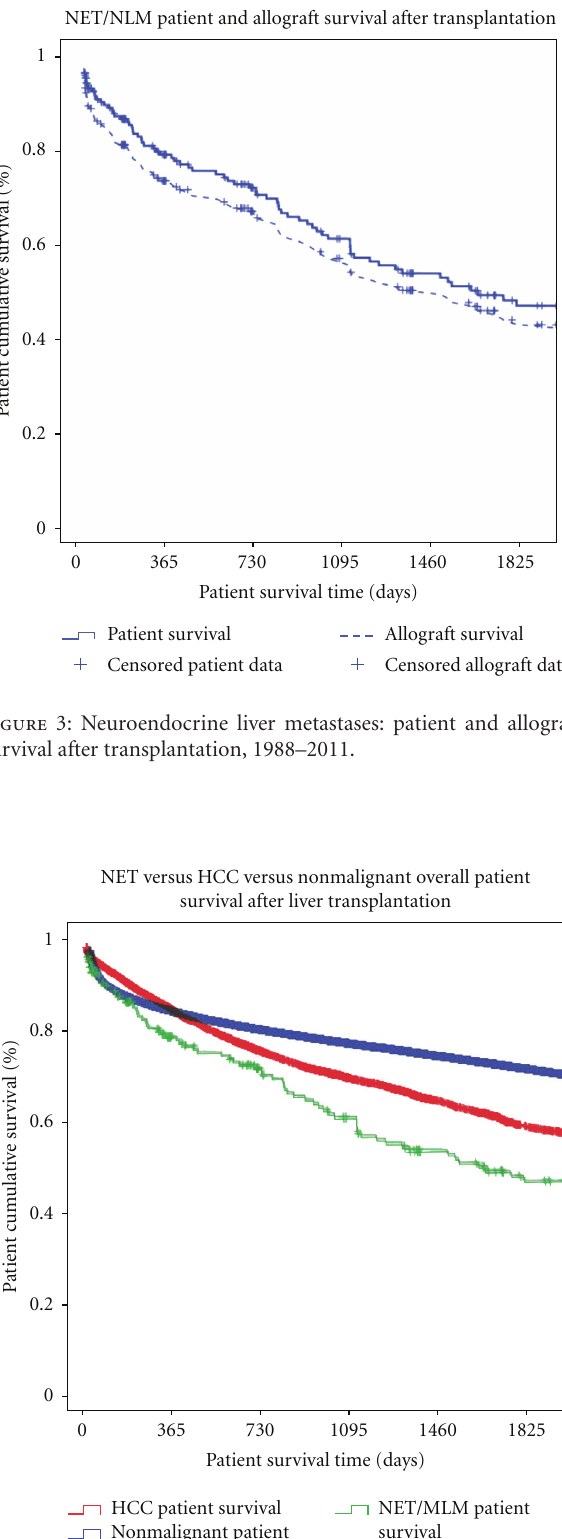
Figure 4: NET/NLM versus HCC versus nonmalignant patient sur- vivals after transplantation, 1988–2011. NET/NLM versus HCC ( P = 0 . 002); NET/NLM versus nonmalignant ( P ≤ 0 . 00).